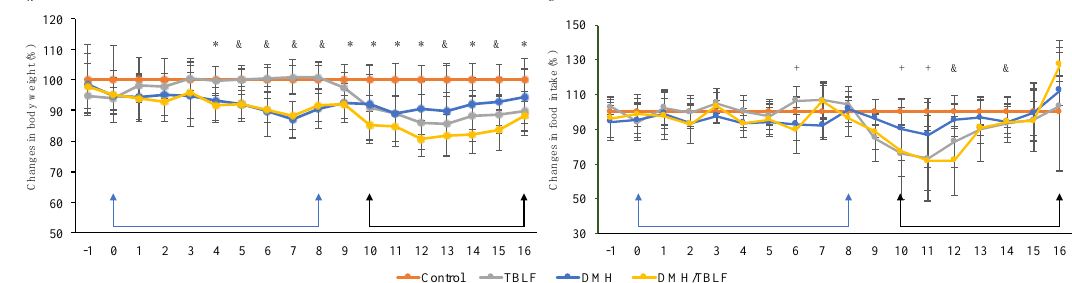
Figure 2. Body weight and food intake changes for the 1,2-dimethylhydrazine (DMH) experiment. Rats were administered DMH for eight weeks for the development of cancer lesions (blue arrows), followed by intra-gastric administration of TBLF (50 mg/kg) on alternate days for six weeks (black arrows). ( A ) Weekly body weight monitoring with respect to the control group. ( B ) Average of food intake changes per week with respect to the control group. A one-way ANOVA by Dunnett post hoc showed significant difference p ≤ 0.05 (*), p ≤ 0.01 (+) and p ≤ 0.001 (&). TBL provoked a decrease in weight gain that affected also the combined DMH/TBLF treatment. Food intake decreased through TBLF administration but a final recovery was observed.